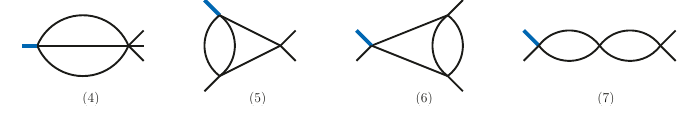
captured by the s 12 triple cut (b) in (cid:12)gure 5. O 1